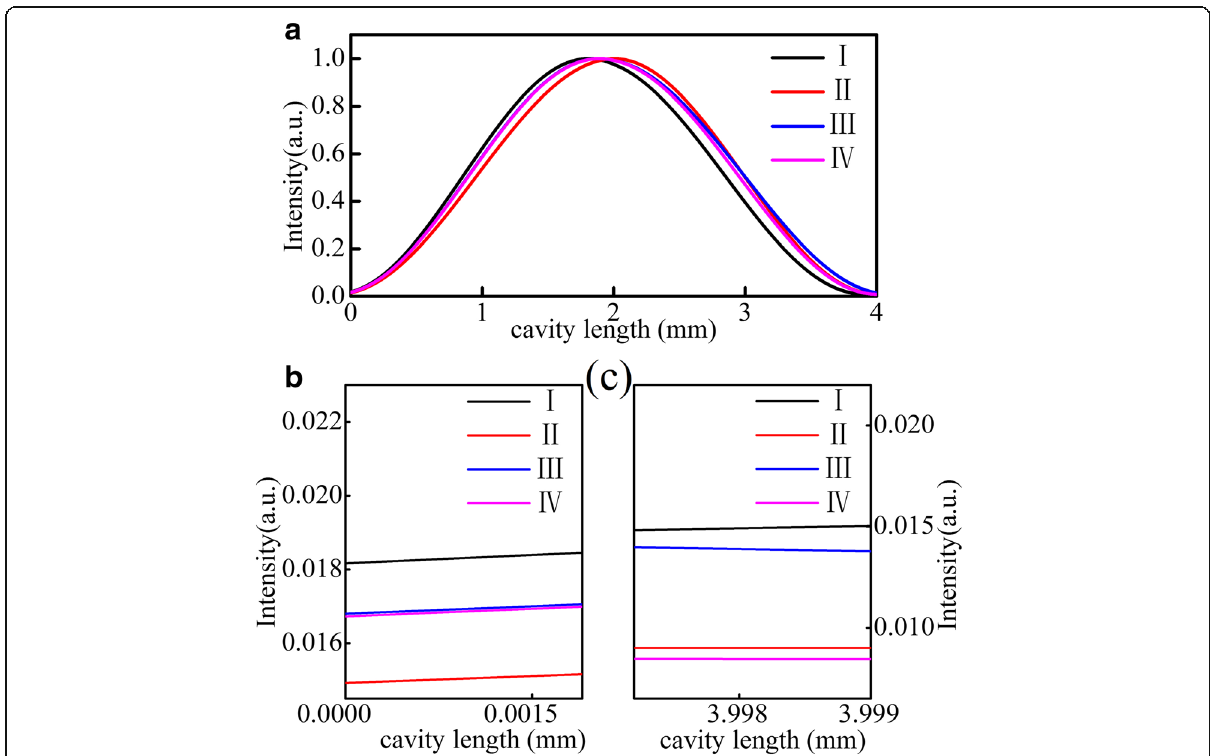
Fig. 2 a The corresponding optical field distribution of the uniform grating structure for the four kinds of cleaved end facet positions of I, II, III, and IV. b , c The amplification of the optical field distribution near the two end facets